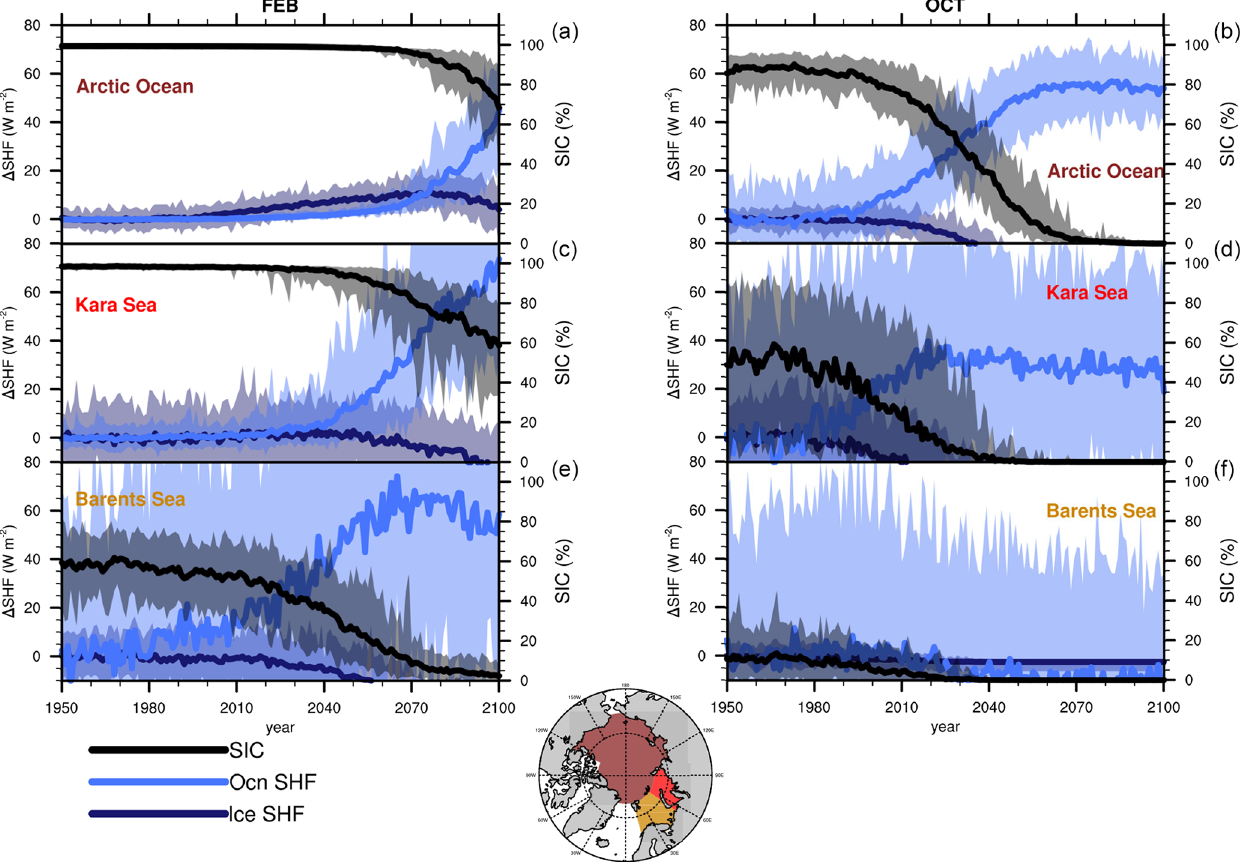
Figure 5. CESM1-LE area-averaged anomalies (from the 1950–1959 ensemble mean) for sea ice and ocean contributions to net surface heat fluxes (left axis) and sea ice concentrations (right axis) for February (a, c, e) and October (b, d, f) for the Arctic Ocean (a, b) , Kara Sea (c, d) , and Barents Sea (e, f) . Ensemble means are shown as solid lines; ensemble ranges are opaque polygons. Geographic areas are shown in the inset at the